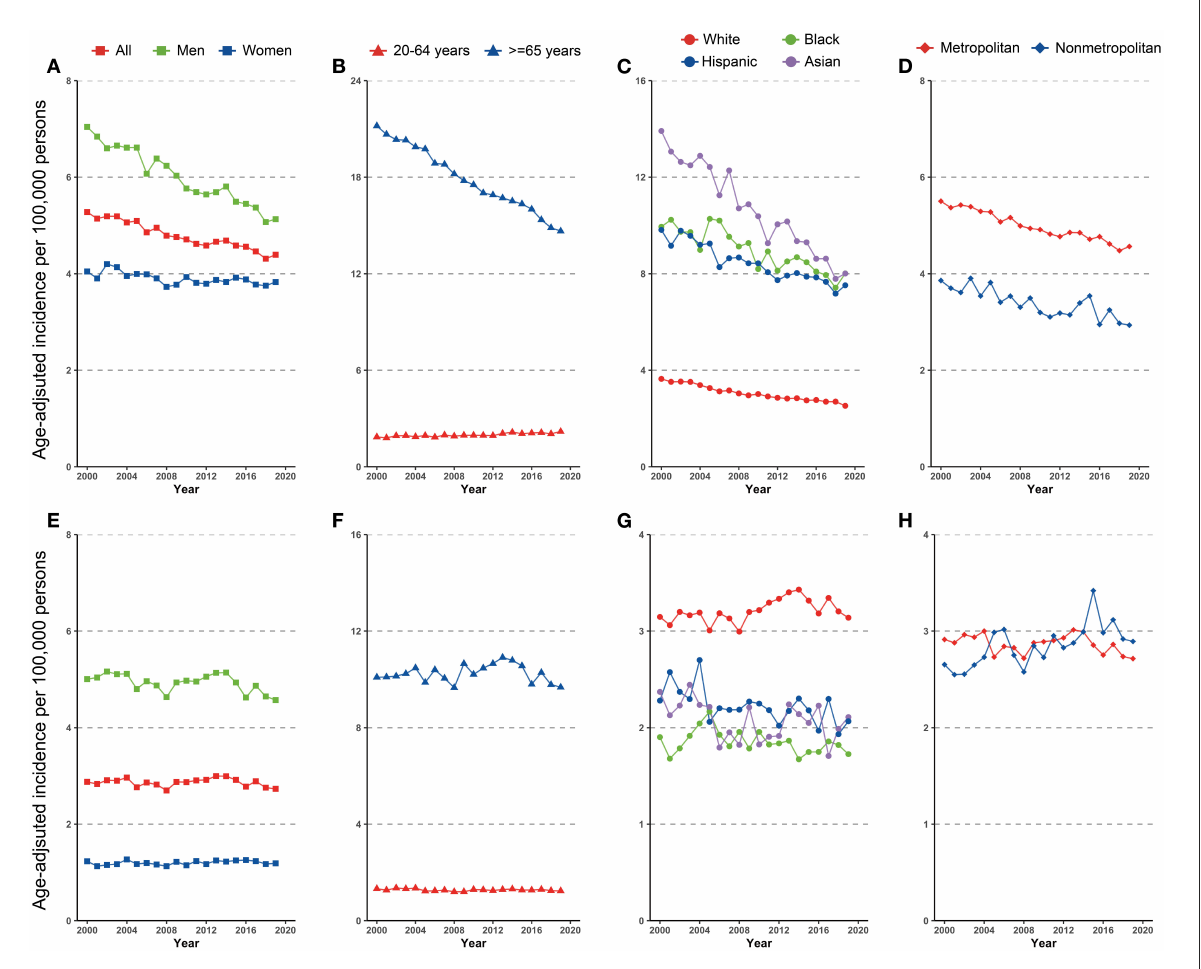
FIGURE1 Incidence trend in gastric cancer among US adults, 2000–2019 (A–D) cardia gastric cancer by sex, age, race/ethnicity, and geographic location (E–H) non-cardia gastric cancer by sex, age, race/ethnicity, and geographic location.